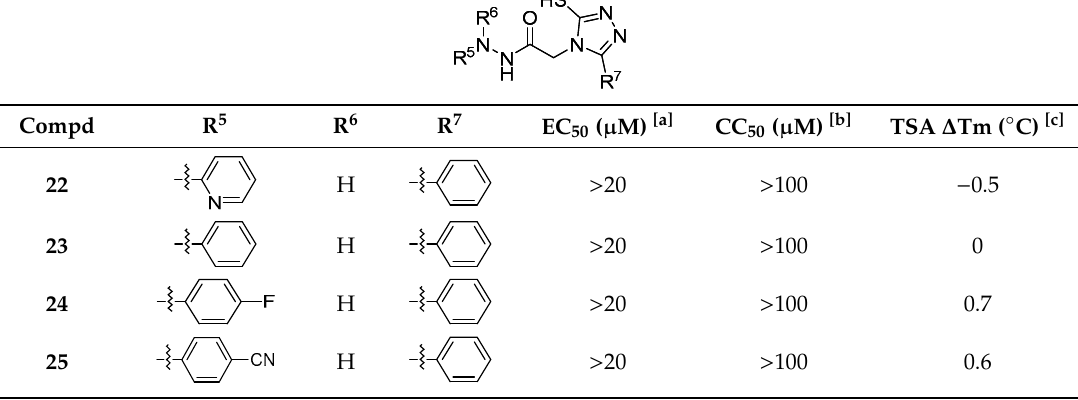
Table 3. Anti-HIV-1 activity, cytotoxicity, and CA hexamer stability profiles of 22–39 (R 5 , R 6 , and R 7 ). Compd